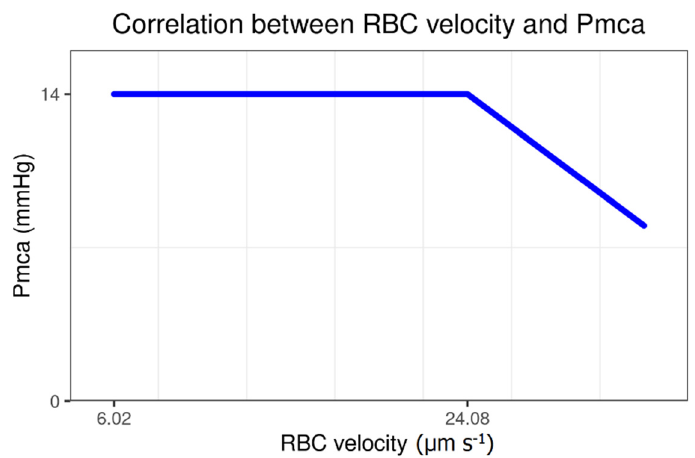
Figure 3. Correlation of Pmca with sublingual microcirculation RBC velocity in individuals with steady-state physiology, effective coupling between the macro- and microcirculation, and normal tissue oxygen extraction ratio. A constant Pmca of 14 mmHg was observed in individuals with RBC velocity 6–24 μ m s –1 , while a Pmca of <14 mmHg was observed in those with RBC velocity > 24 μ m locity 6–24 µ m s − 1 , while a Pmca of <14 mmHg was observed in those with RBC velocity > 24 µ m s − 1 . s –1 . Pmca, mean circulatory filling pressure analogue; RBC, red blood cell. Pmca, mean circulatory filling pressure analogue; RBC, red blood